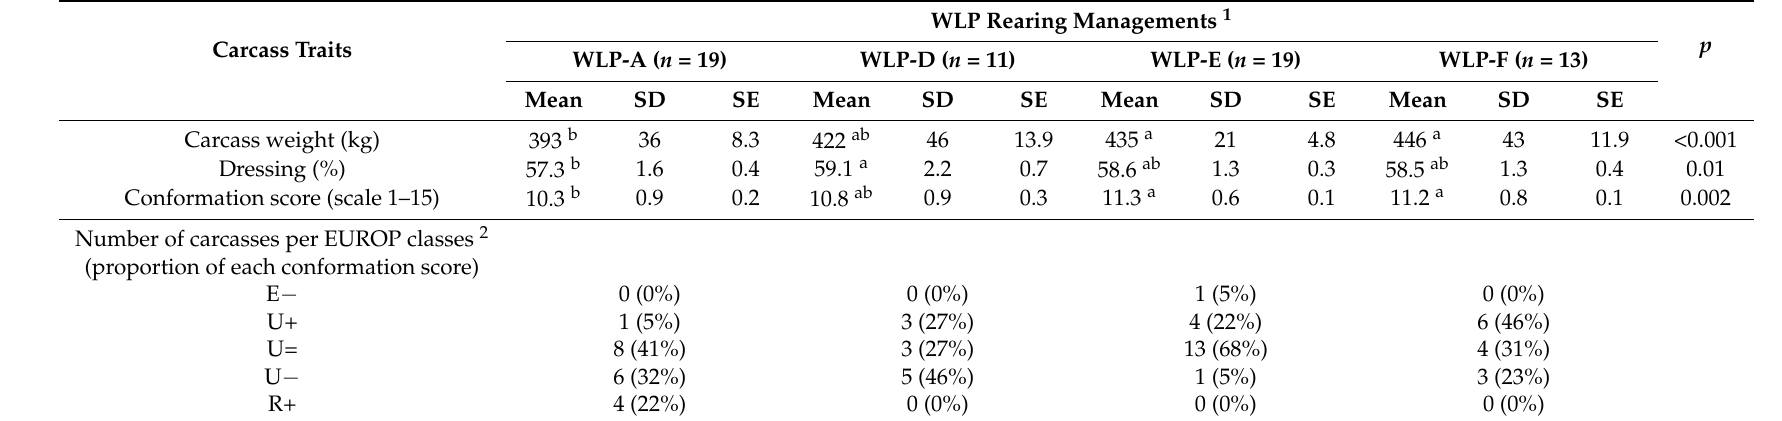
Table 5. Impact of the four rearing managements applied during the heifers’ whole life period (WLP) on carcass traits.